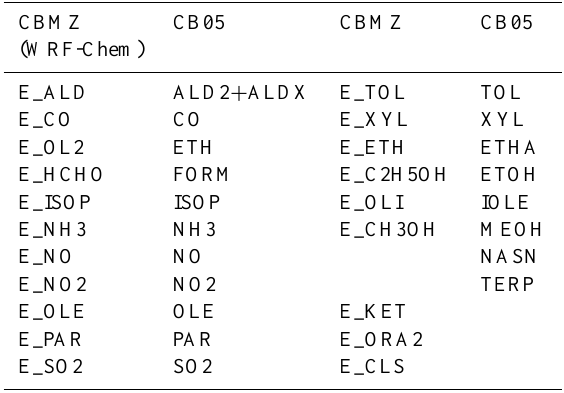
Table 2. Species mapping between the CB05 and CBMZ chemical